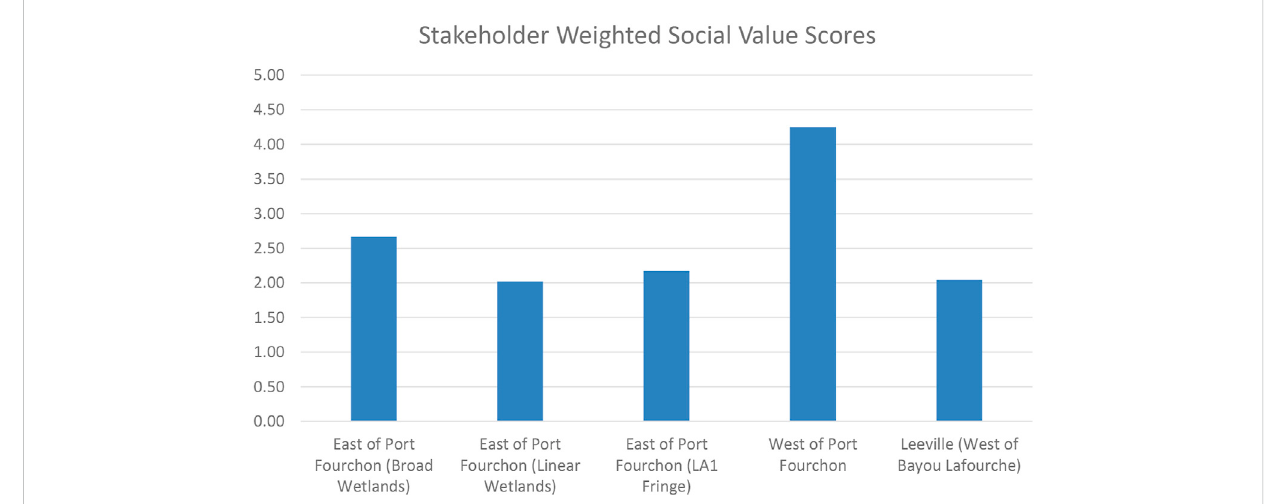
FIGURE 4 Final stakeholder weighted SROI scores for each project grouping analyzed during stakeholder